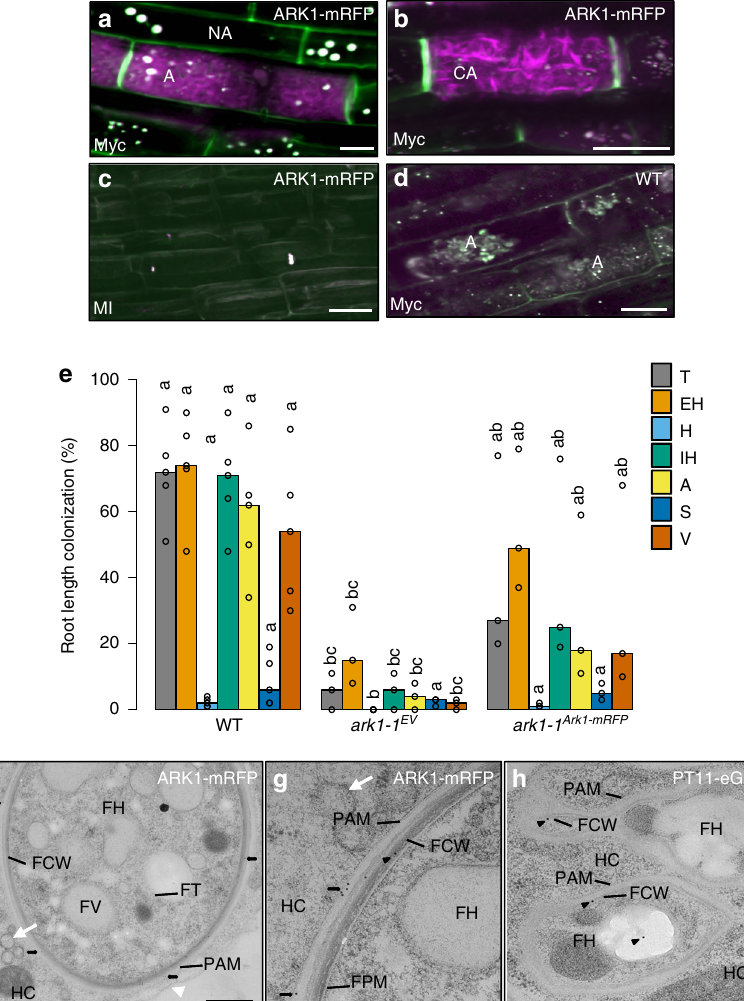
Fig. 4 ARK-mRFP localizes to the peri-arbuscular membrane. Multiphoton laser scanning microscopy ( a − d) shows subcellular localization of a mRFP (magenta) signal labels PAM around arbuscule fi ne branches (A) at 20 days post-inoculation (dpi). Auto fl uorescence from plant cell walls and auto fl uorescent bodies are false colored in green and white, respectively. NA nonarbusculated cell. Scale bar 10 μ m, z-stack 10 μ m. b ARK1-mRFP localizes to PAM surrounding collapsing arbuscular (CA) fi ne hyphae. Scale bar 30 μ m, z-stack 20 μ m. c Mock-inoculated (MI) ARK1-mRFP-expressing roots and d nontransformed colonized WT lack RFP signal; c , d Scale bar 15 μ m, z-stack 10 μ m. Representative images of three roots from at least three plants are provided. e Quanti fi cation of R. irregularis root colonization levels of the ark1-1 mutant containing the empty vector (EV) control or pARK::ARK-mRFP . T total colonization, EH extra-radical hyphae, H hyphopodia, IH intra-radical hyphae, A arbuscules, S spores, V vesicles. For statistical analysis Kruskal − Wallis tests with the Holm adjustment method were performed using the agricolae package and selecting the option for “ treatment groups formation ” with P value set at ≤ 0.05. Bars show median levels while the letters above each bar indicate colonization values that were not signi fi cantly different in the post hoc pairwise comparisons. f − h Transmission electron micrograph (TEM) shows immuno-gold labeling (IGL) of ARK1-mRFP to the PAM ( f , g ) using an RFP antibody and secondary antibody conjugated to 10-nm immuno-gold particles (black arrows) and not to ER (white arrow) or host tonoplast (white arrowhead). Black arrowheads show nonspeci fi c labeling to the fungal cell wall (FCW). Scale bar 500 nm ( f ) and 100 nm. Representative images from arbuscule-containing cells ( n > 4) of independently sampled roots derived from two different experiments ( g ). h PT11-eGFP control roots cross-reacted with RFP antibodies, showing nonspeci fi c labeling (black arrowheads) of the FCW. Scale bar 100 nm. HC host cytosol, FH fungal hypha, FT fungal